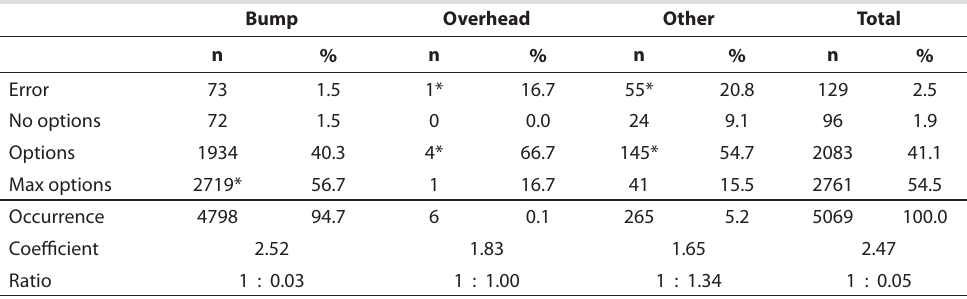
TABLE 1 Technique used in reception and efficacy in men’s beach volleyball